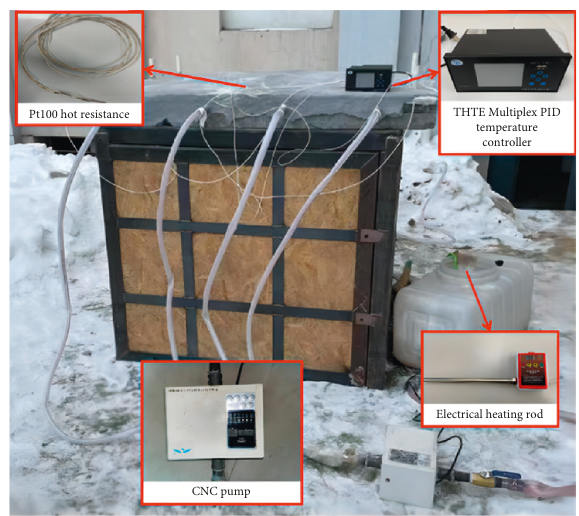
Figure 5: Overall layout of an outdoor exposure